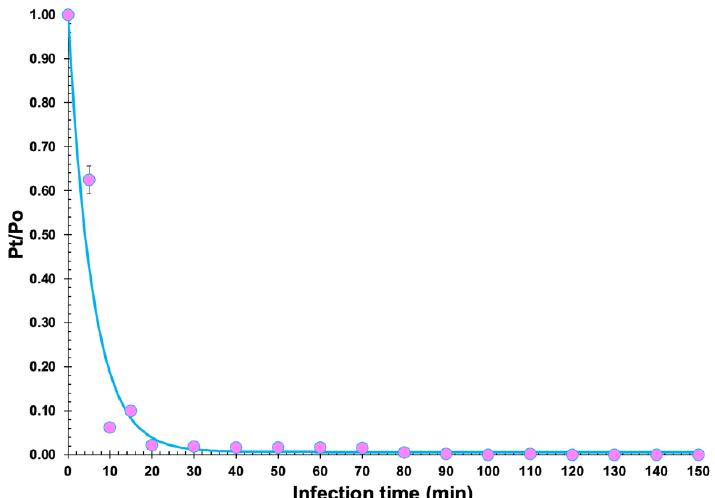
Figure 7. Adsorption curve of the phage Kpn31 onto K. pneumoniae CCCD-K001 cells, displaying the non-linear fitting of a negative exponential function to the experimental data. Values represent the means of three independent assays. Error bars represent the standard deviations. The values of the parameters obtained from the nonlinear fitting of the adsorption model to the experimental data were δ = 1.700 × 10 − 9 PFU − 1 CFU − 1 mL − 1 h − 1 (phage adsorption rate) and ϕ = 0.00110 h − 1 (phage desorption rate) (X 0 = 1.0 × 10 8 CFU/mL).